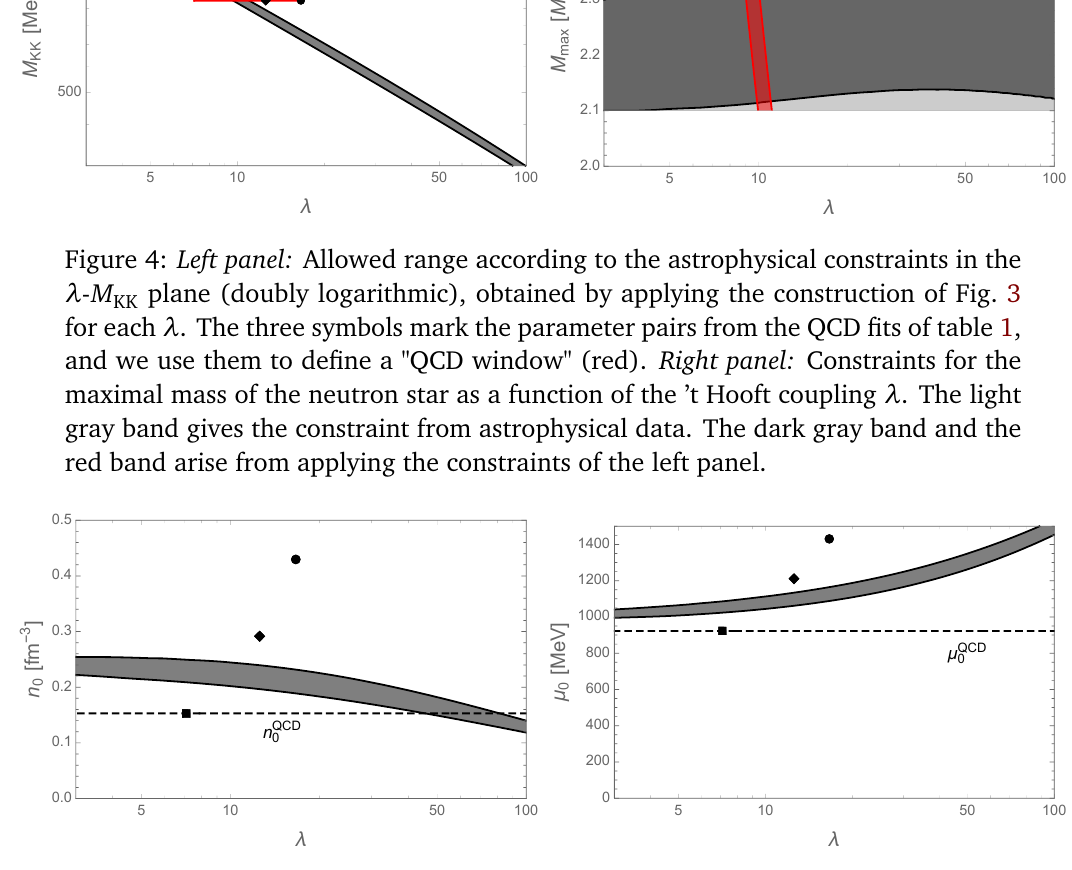
Figure 5: Saturation density of symmetric nuclear matter (left) and corresponding onset chemical potential (right) as functions of λ for the astrophysically allowed parameter band, see left panel of Fig. 4, and for the three fits of table 1. The dashed horizontal lines indicate the real-world